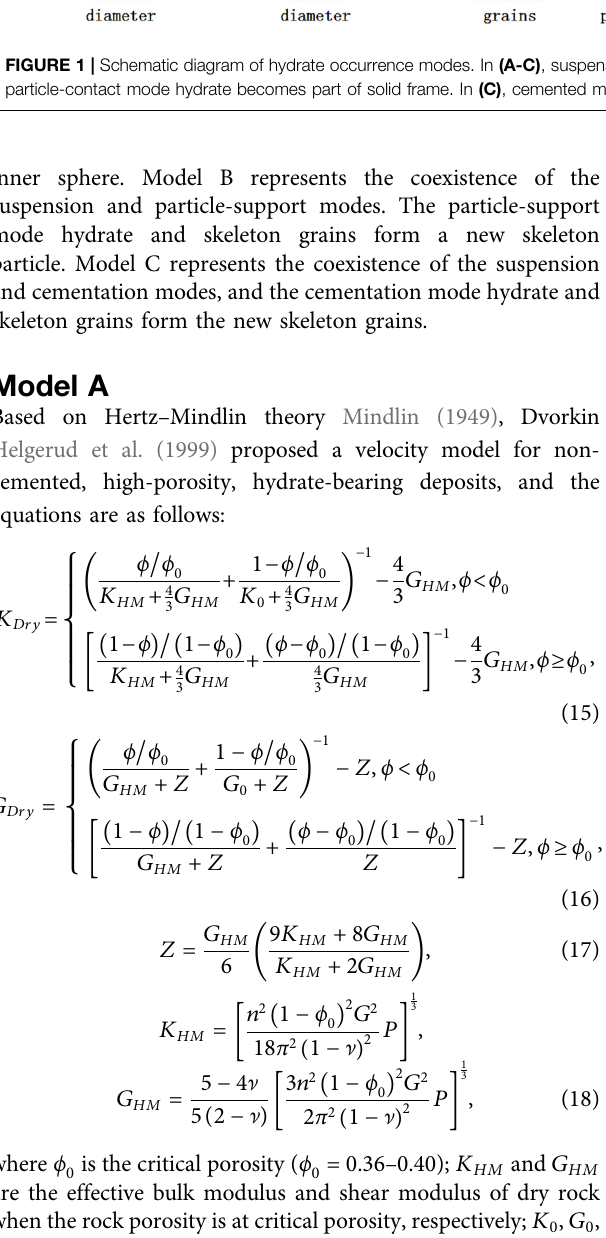
Frontiers in Earth Science |